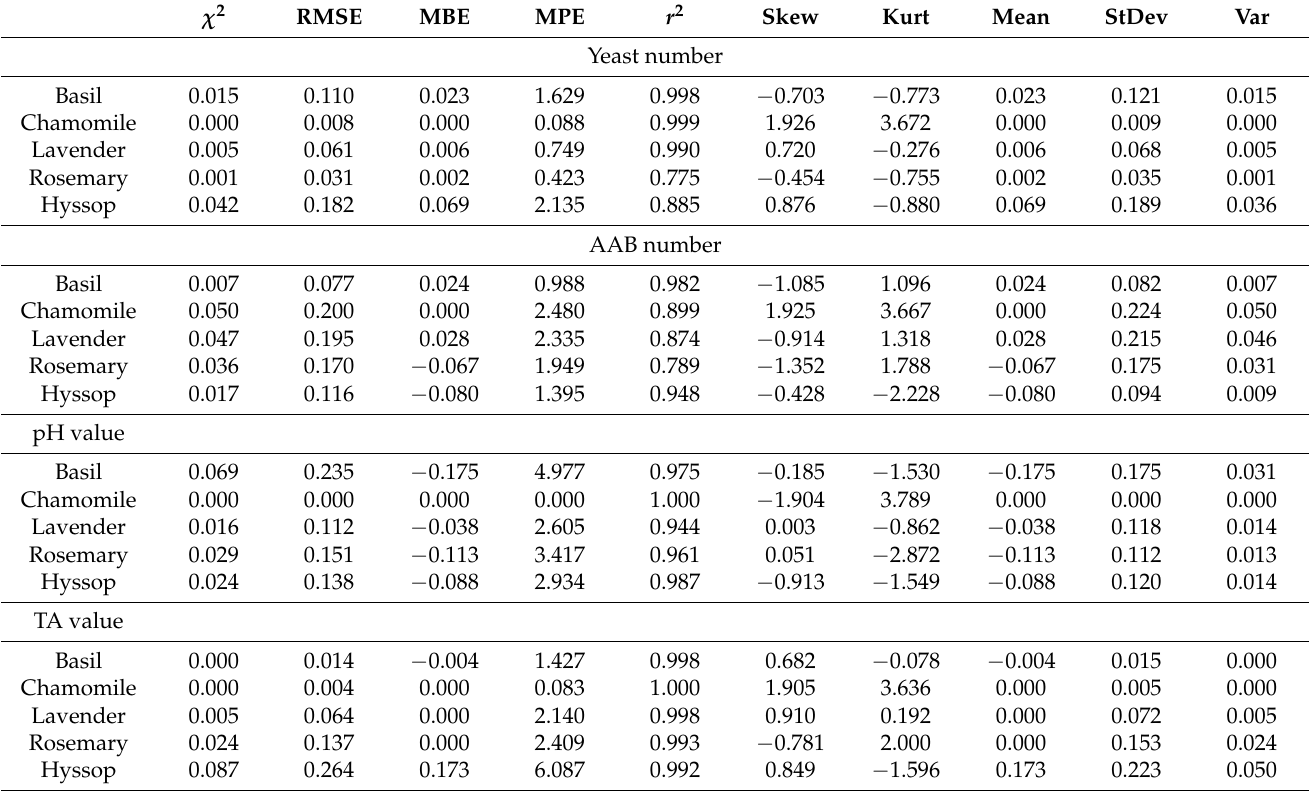
Table 2. The “goodness of fit” kinetics